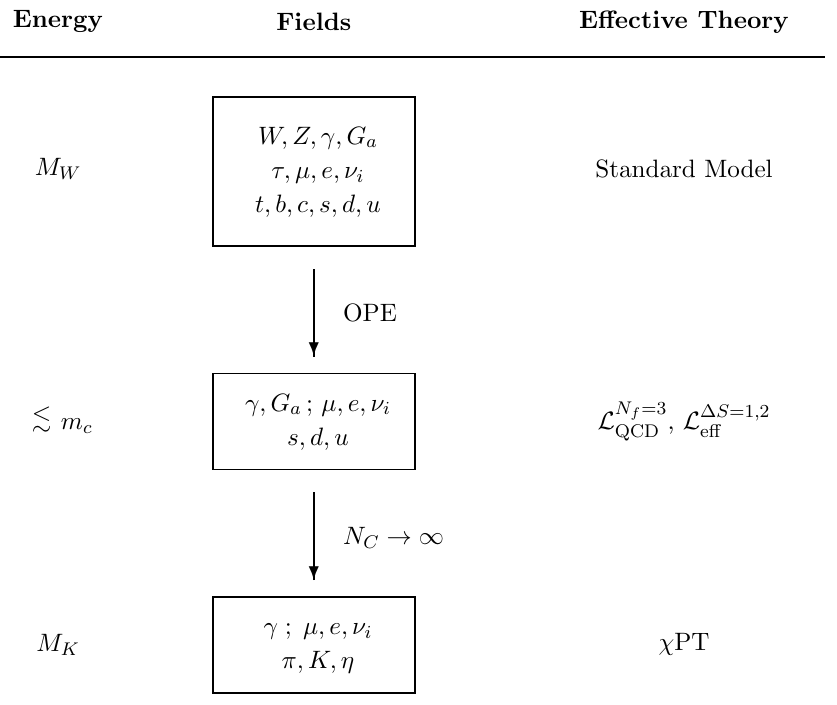
Figure 1 . Evolution from M W to the kaon mass